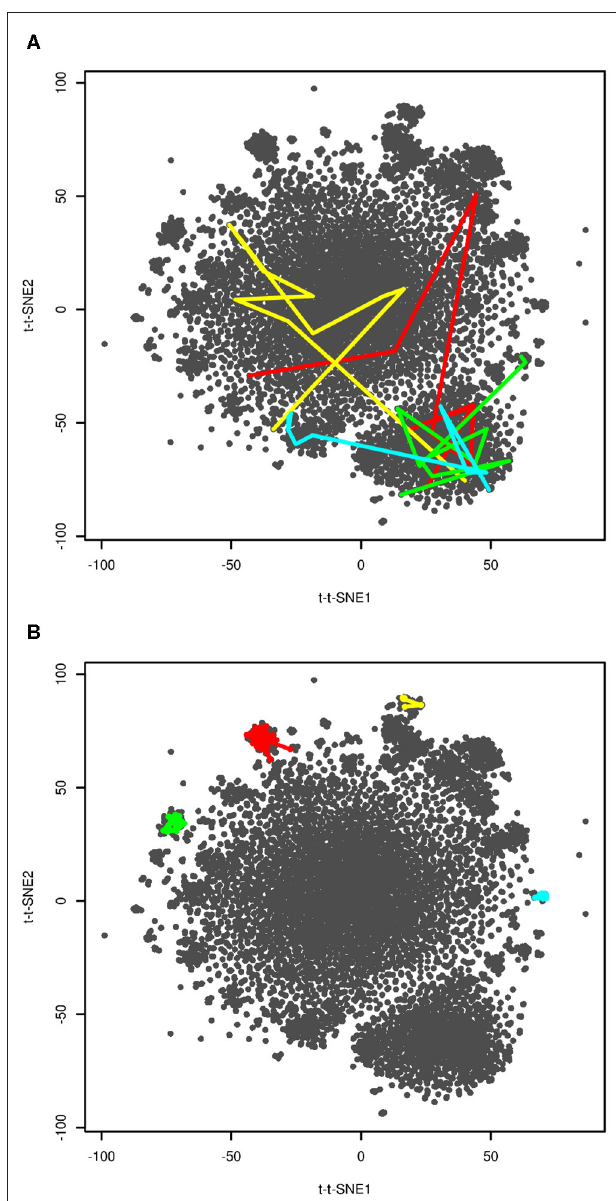
FIGURE 4 | Visualization of folding events (A) and kinetic traps (B) . Four selected folding events (at approx. 20, 40, 104 and 206 µ s in red, yellow, green, and blue, respectively) are depicted as last 10 frames (200 ns) before reaching t-t-SNE2 < − 75. Four selected kinetic traps on edges of the plot are depicted as connected series of snapshots. These regions were sampled for 800 (red), 140 (yellow), 400 (green), and 460 (blue)